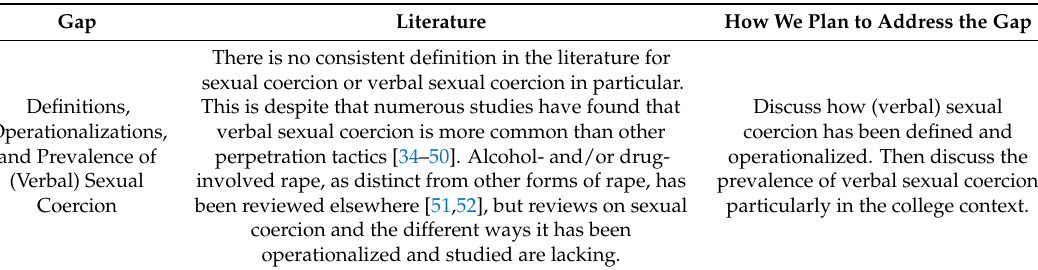
Table 1. Research Gaps and Our Plan to Address